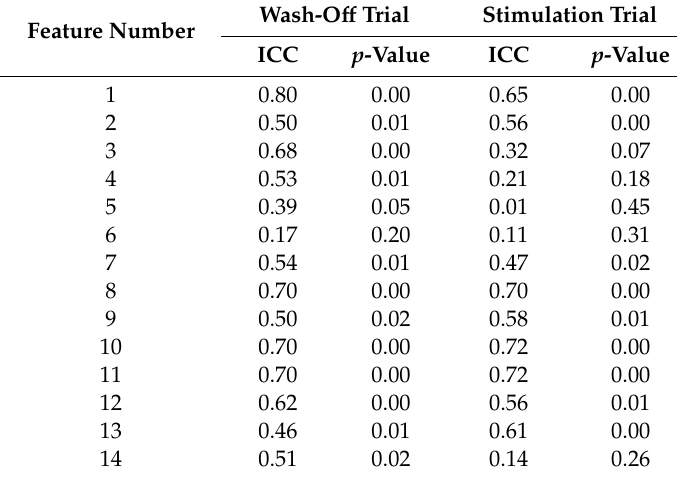
Table 2. Intraclass correlation coe ffi cient (ICC) of 14 features. Wash-O ff Trial Stimulation Trial Feature Number ICC p -Value ICC p